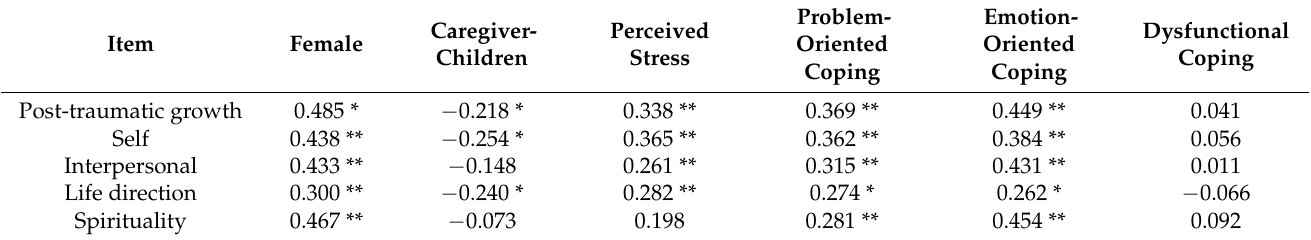
Table 3. Caregivers’ perceptions of stress, coping strategies, and post-traumatic